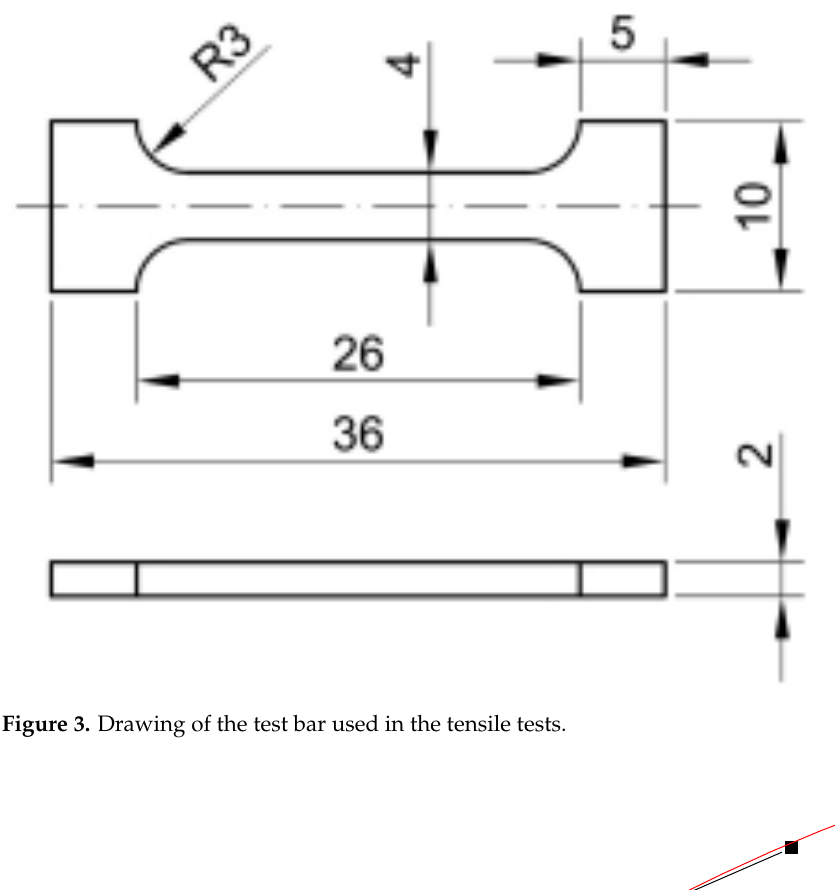
9 of 24 Table 2. Selected predicted parameters for n =  7–26  . n